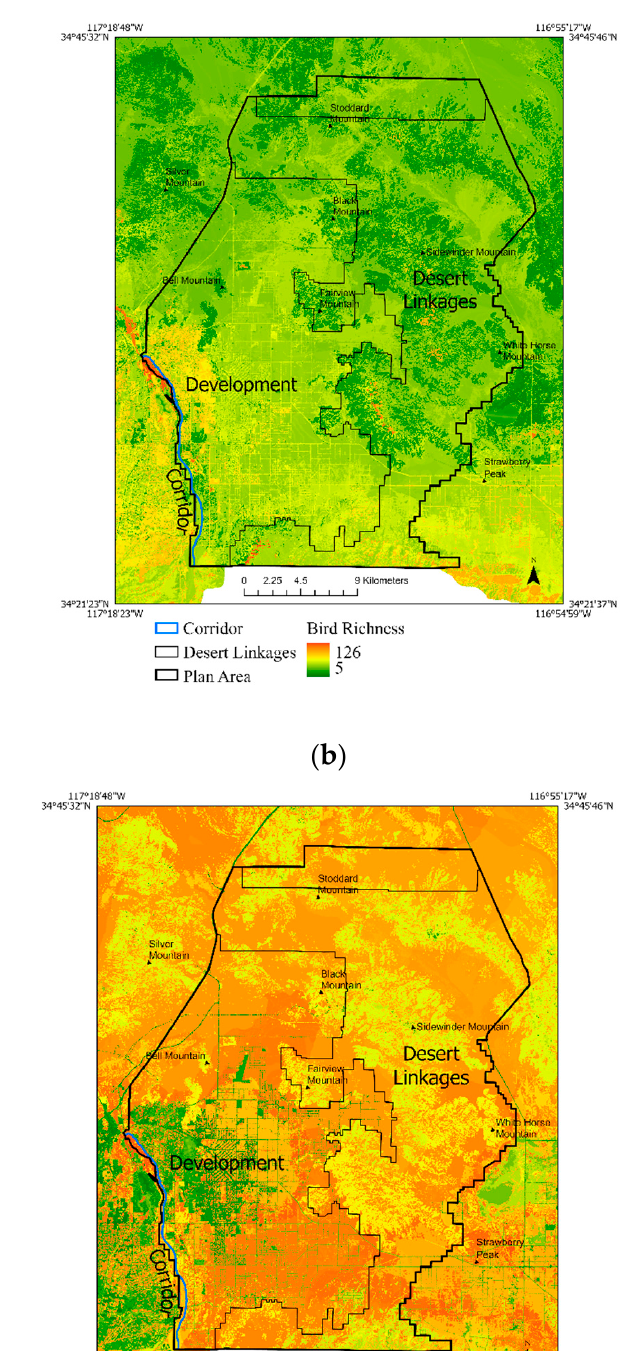
Figure 2. Total Vertebrate Species Richness within ( a ) San Bernardino County and ( b ) the Apple Valley Multi-Species Habitat Conservation Development zone, Linkages, and Mojave River Corridor.